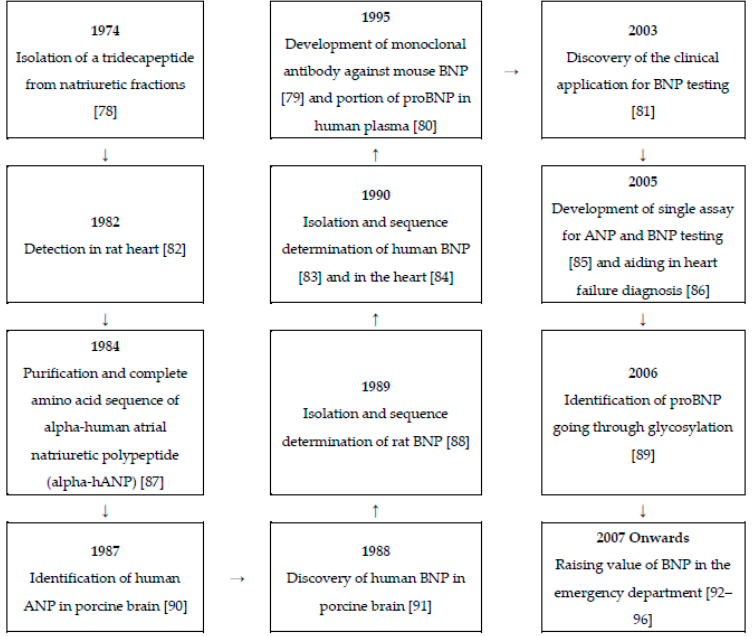
Figure 2. Timeline of the research developments on natriuretic peptides [78–96].